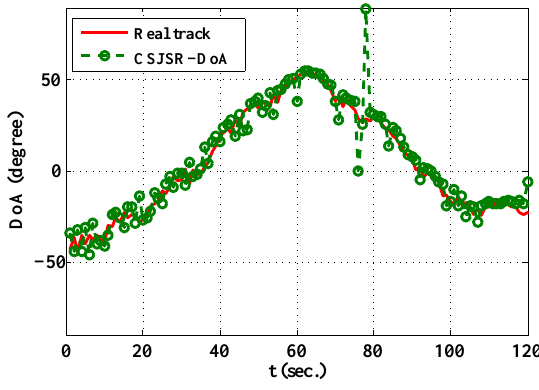
Figure 11. Experiment result of the CSJSR-DoA